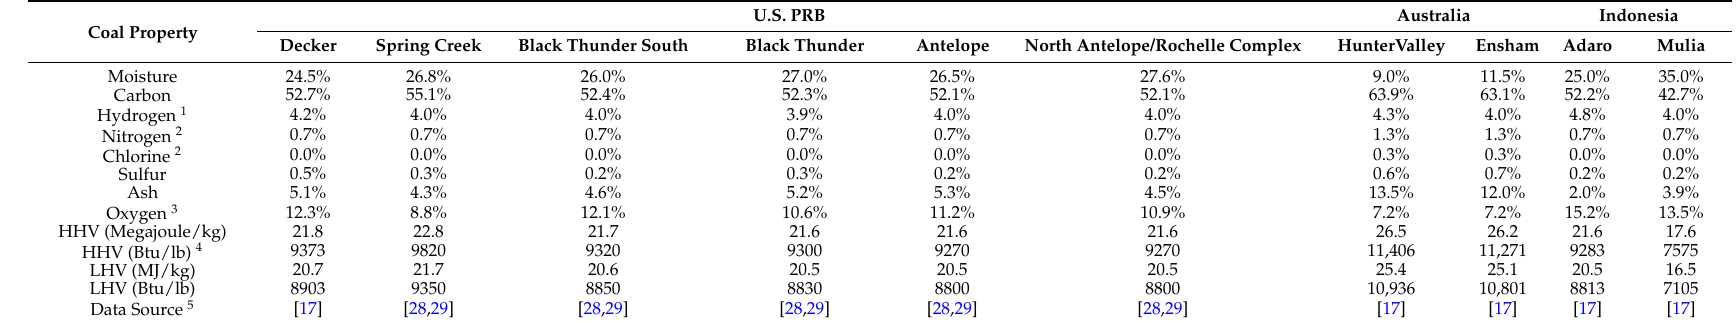
Table 1. Coal quality data for export-grade